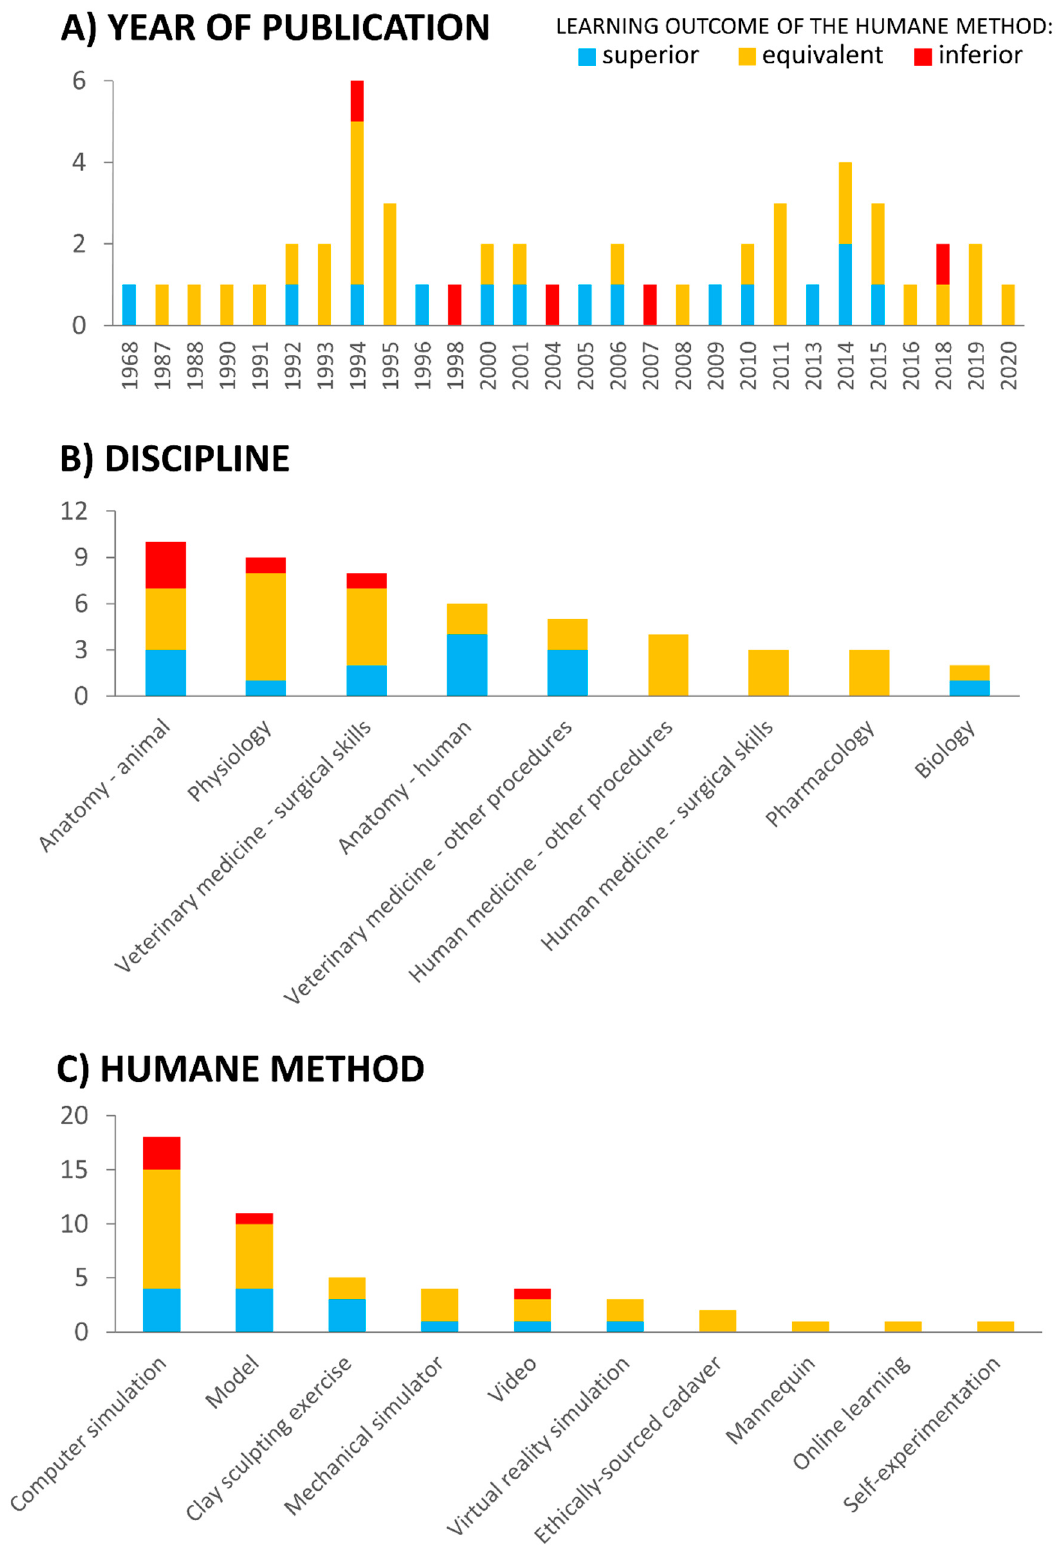
Figure 2. Number of studies comparing learning outcomes of humane teaching method and harmful animal use: ( A ) from 1968–2020, ( B ) grouped by discipline and ( C ) by humane method used. Note: Years with zero publications are not included in ( A ).